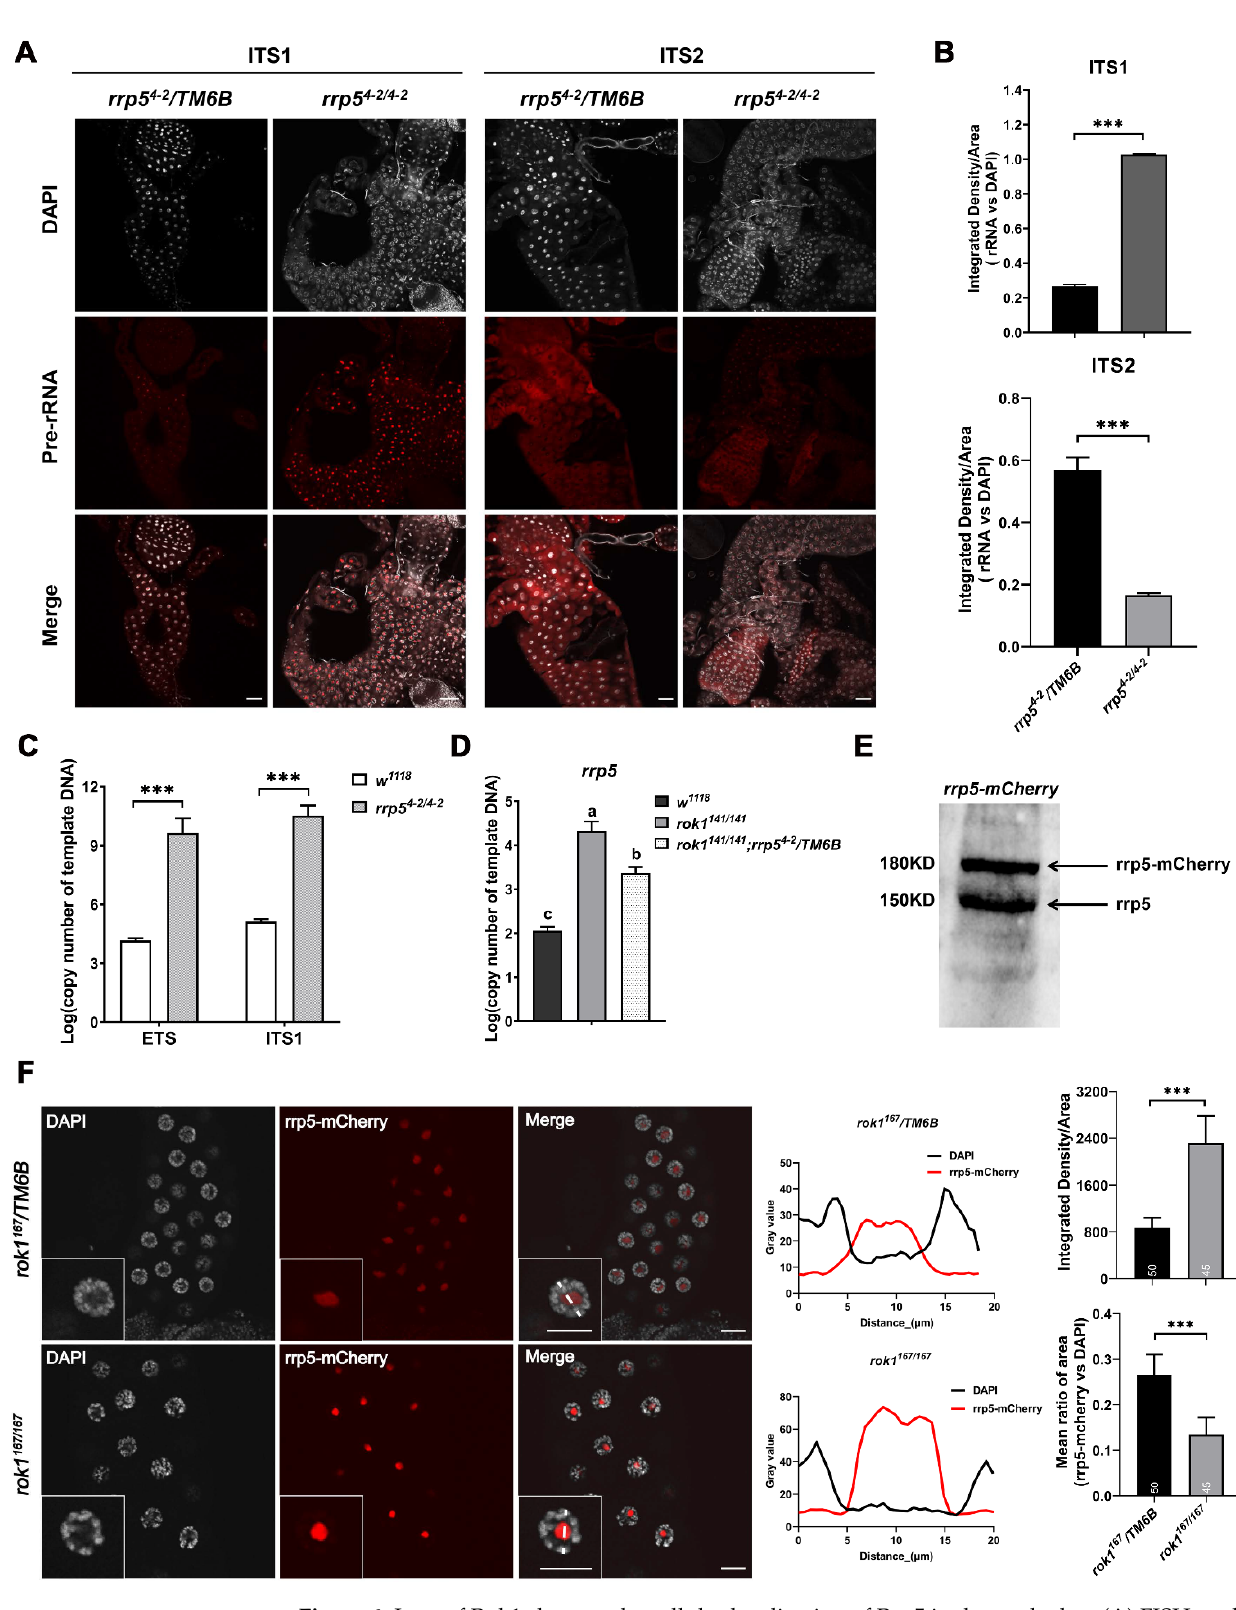
Figure 6. Loss of Rok1 changes the cellular localization of Rrp5 in the nucleolus. ( A ) FISH analyses of pre-rRNA localization using ITS1 and ITS2 probes in malpighian tubules. Malpighian tubules were dissected from second-instar larvae of rrp5 4-2 /TM6B and rrp5 4-2/4-2 . Strong signals are shown in the nucleolus, with DNA in white and pre-rRNA in red. Scale bar indicates 40 μm. ( B ) Mean ratios of fluorescence density of ITS1 and ITS2. Each point represents the mean ± SD ( n = 9). *** indicate